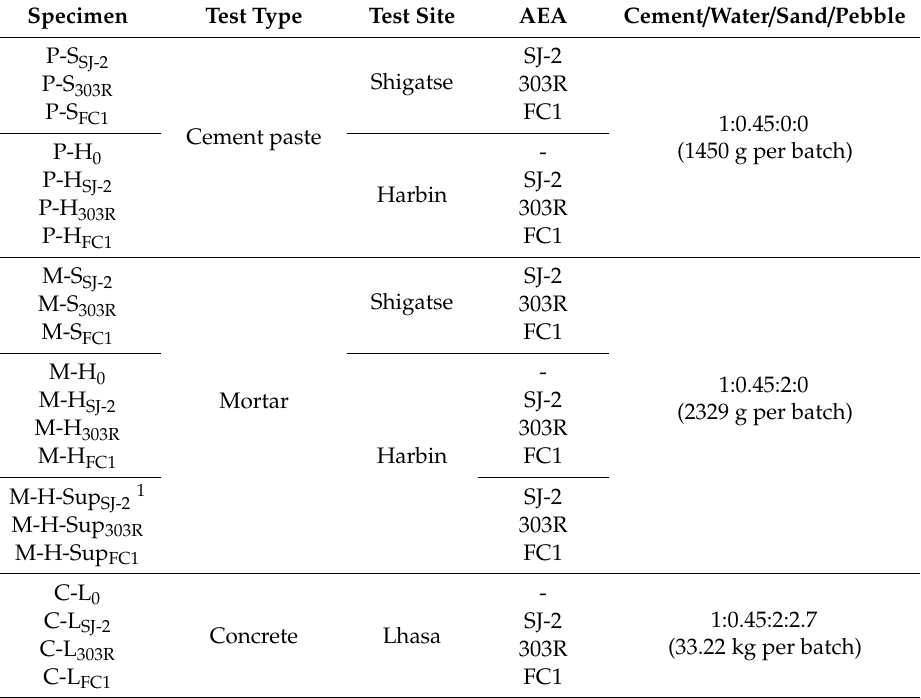
Table 5. Mix proportions of cement-based